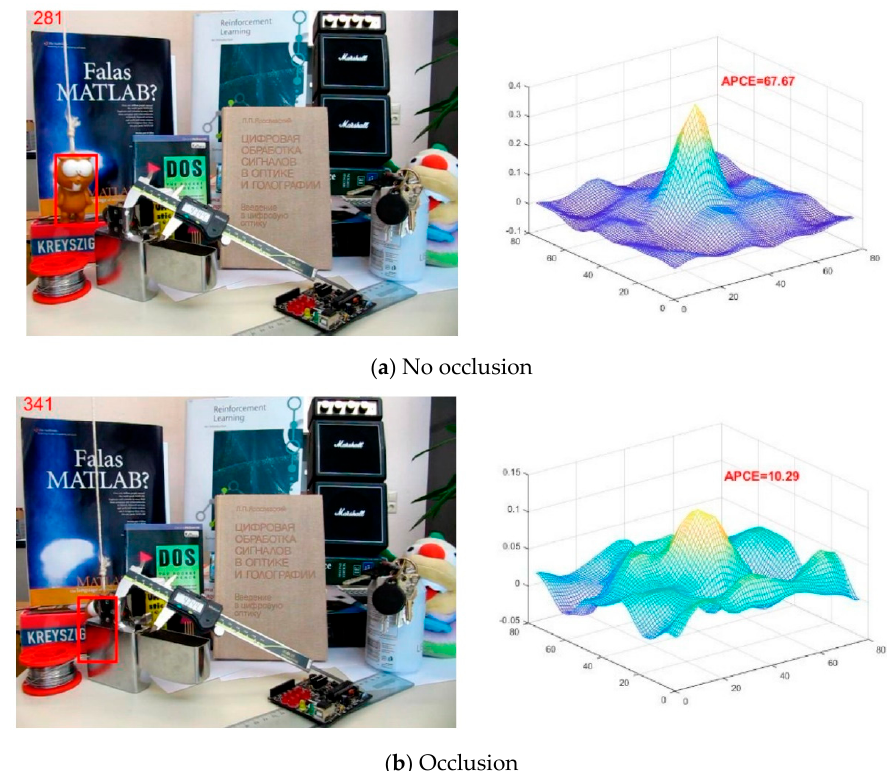
Figure 3. A verage peak-to correlation energy (APCE) values of the response map when the target is Figure 3. Average peak-to correlation energy ( APCE ) values of the response map when the target is occluded or not in two separated frames. occluded or not in two separated frames.